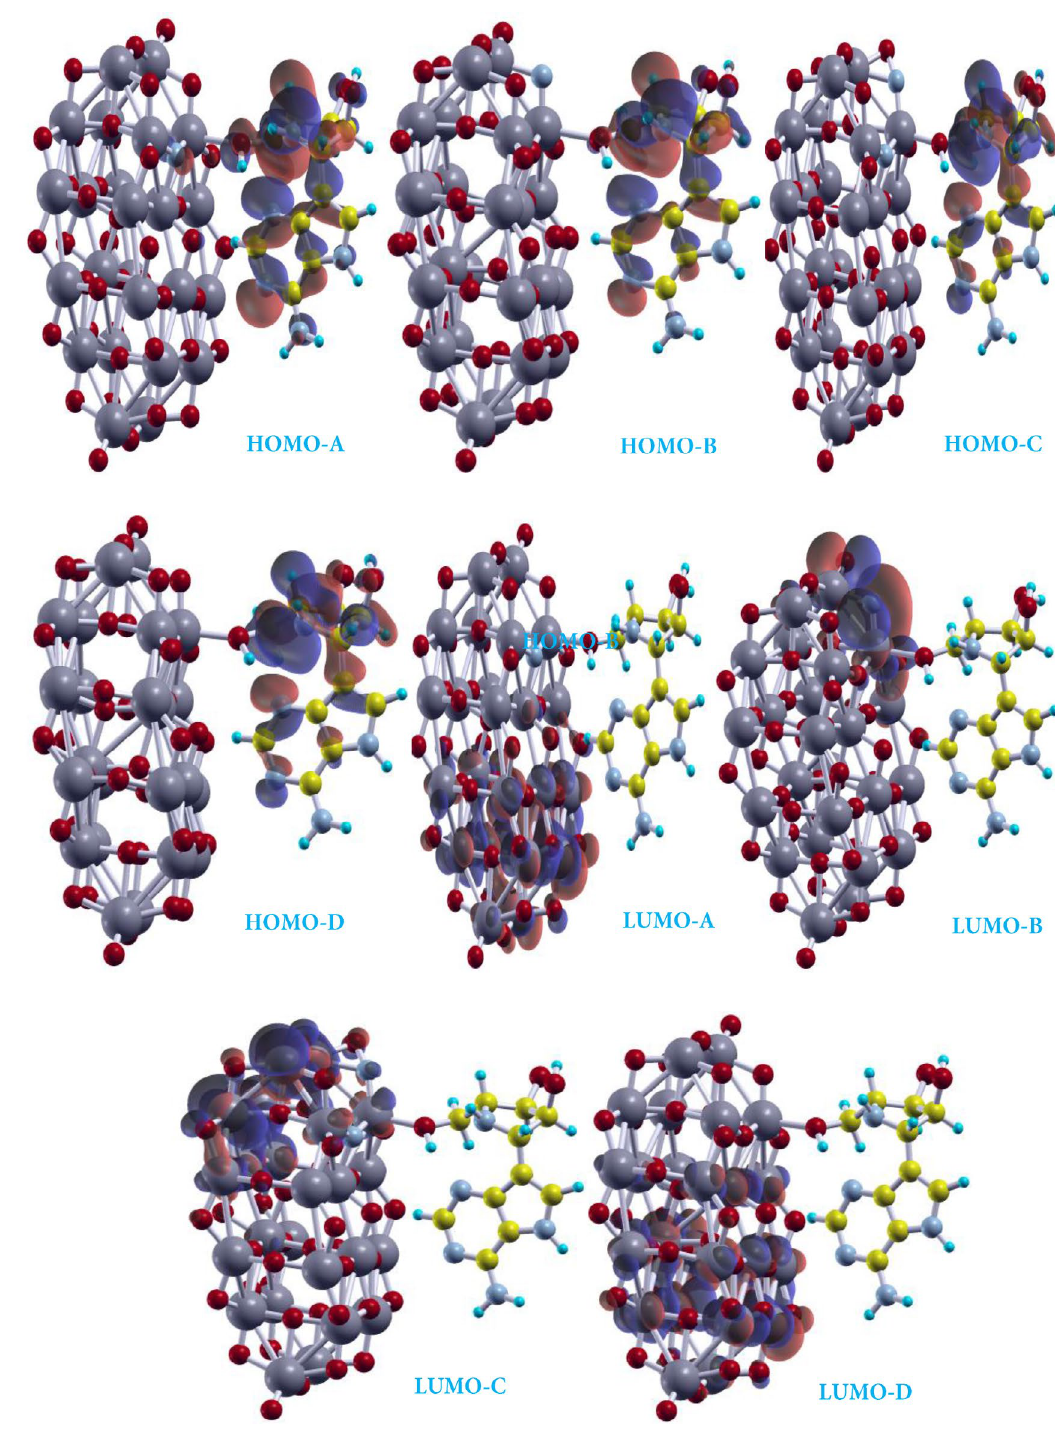
Figure 7. The isosurfaces of HOMO and LUMO molecular orbitals of TiO2-IMMUCILLIN-A adsorption configurations for complexes A-D. Labels A-D refer to the adsorption configurations shown in Figure 3 and HOMO and LUMO mean the highest occupied and the lowest unoccupied molecular